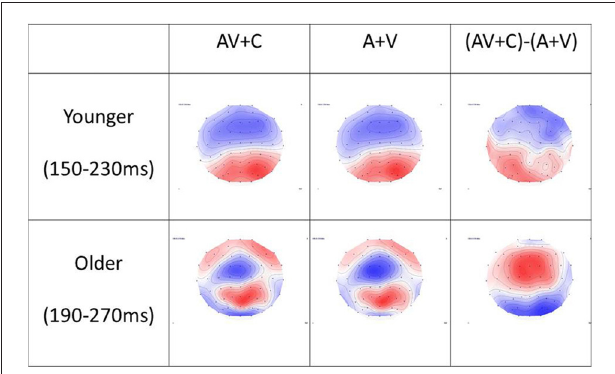
FIGURE 5 | Topography of (A + V), (AV + C) and (AV + C) − (A + V) in younger and older groups. In the younger group, the time window of P2 was chosen as 150–230 ms after stimulus. The topography showed mainly negativity in the fronto-central region and positivity in the parieto-occipital region in all three conditions. In the older group, the time window of P2 was chosen as 190–270 ms after stimulus. Similar topography was observed in the (AV + C) and (A + V) conditions, while reversed topography was shown in the (AV + C) − (A + V) condition in relation to those for the younger group; that is, positivity was shown in the frontal-central region while negativity was shown in the parieto-occipital region, indicating a super-additive pattern in the fronto-central region.